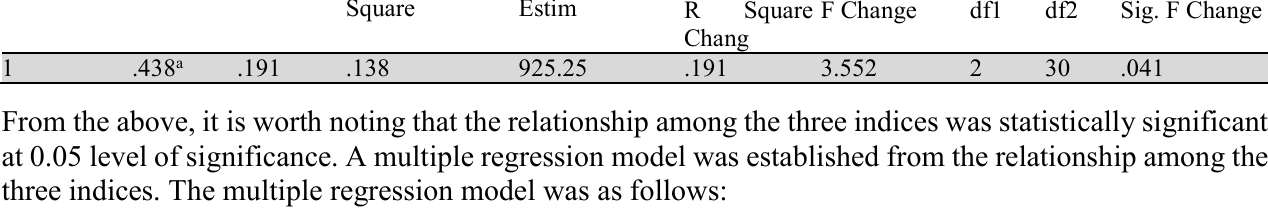
Model Summary on the Influence of Financial Contagion on Performance of NSE 20 Share Index Model